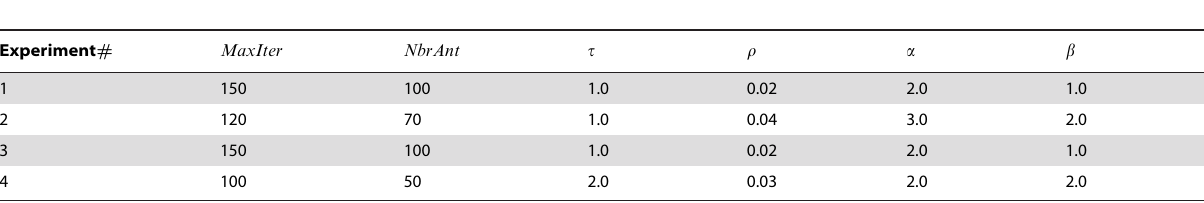
Table 6. ACO parameters